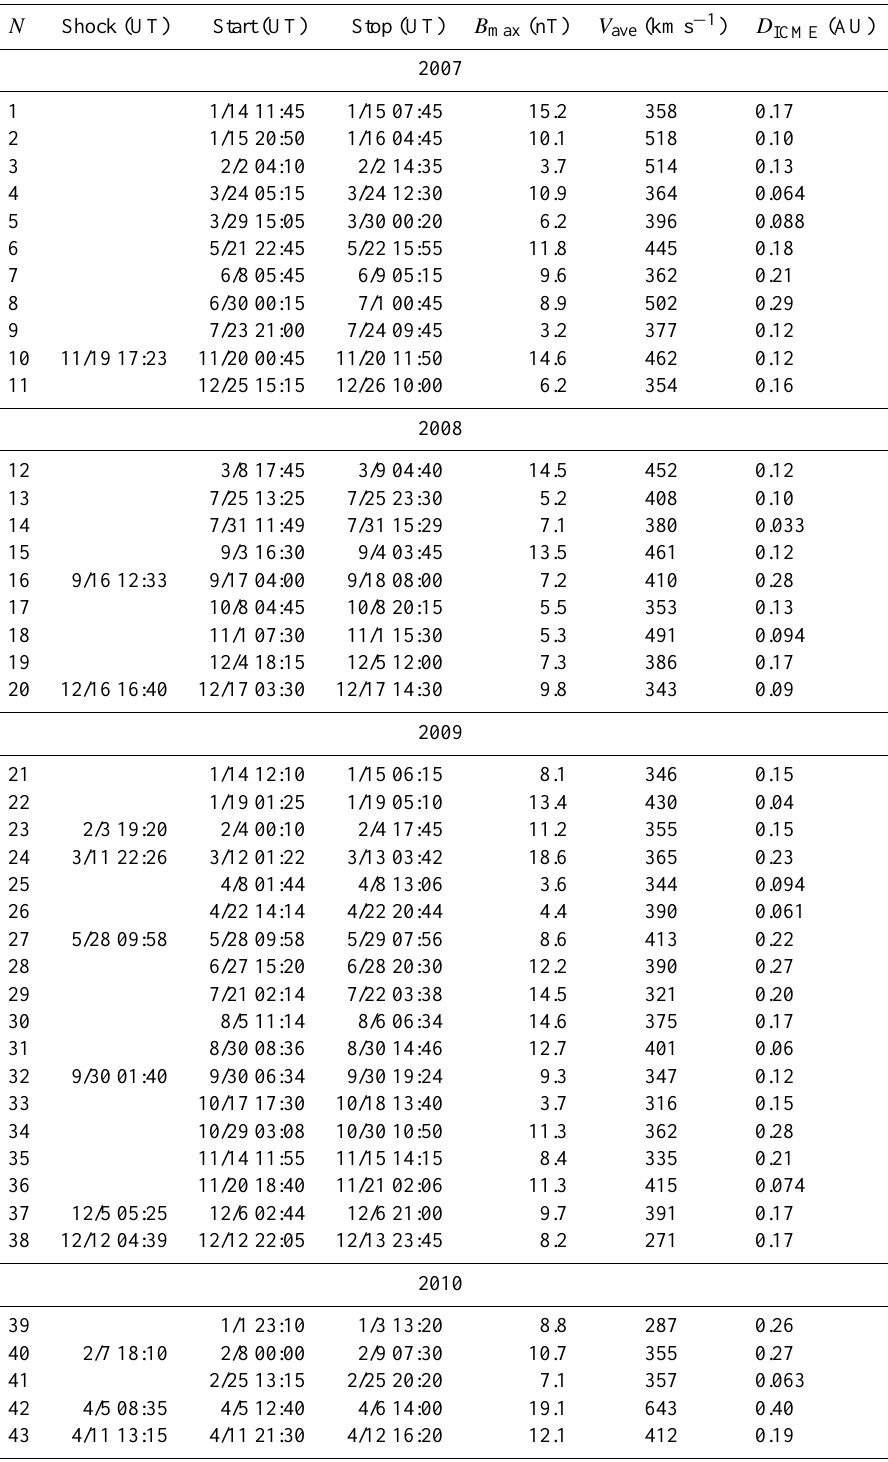
Table 2. ICMEs identified from the OMNI data base from January 2007 to April 2010. The columns are same as in Table